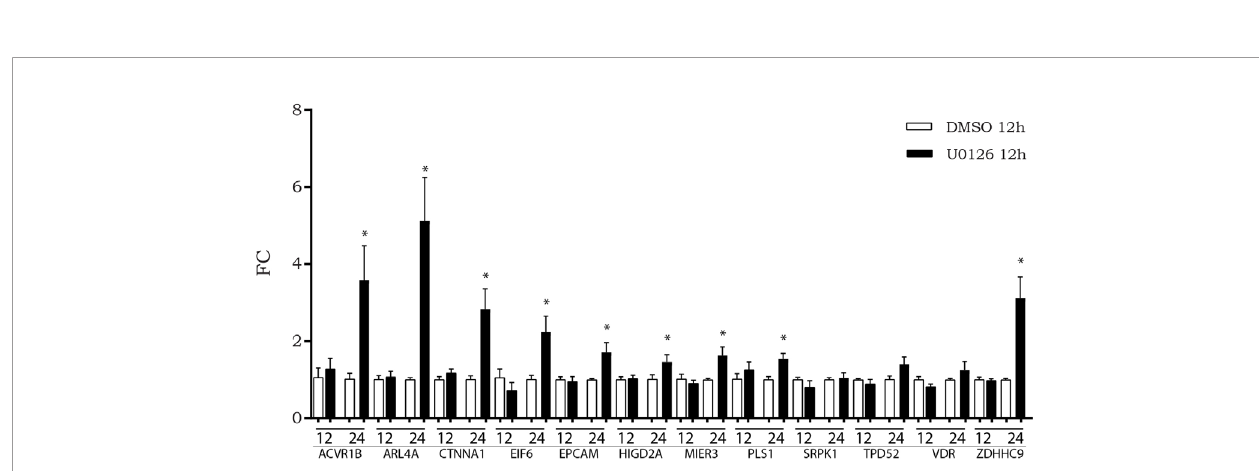
FIGURE 7 | Expression of messenger RNAs (mRNAs) of LINC00483 molecular axes in HCT-116 cells at 12 and 24 h after U0126 treatment. *p-value <